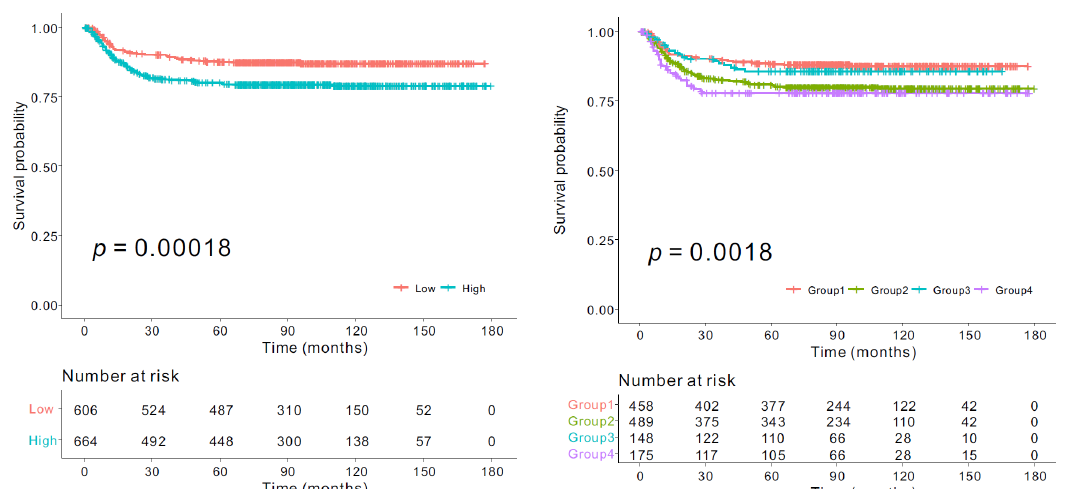
Table 2. Univariate analysis of factors associated with progression-free survival ( n = 1270).